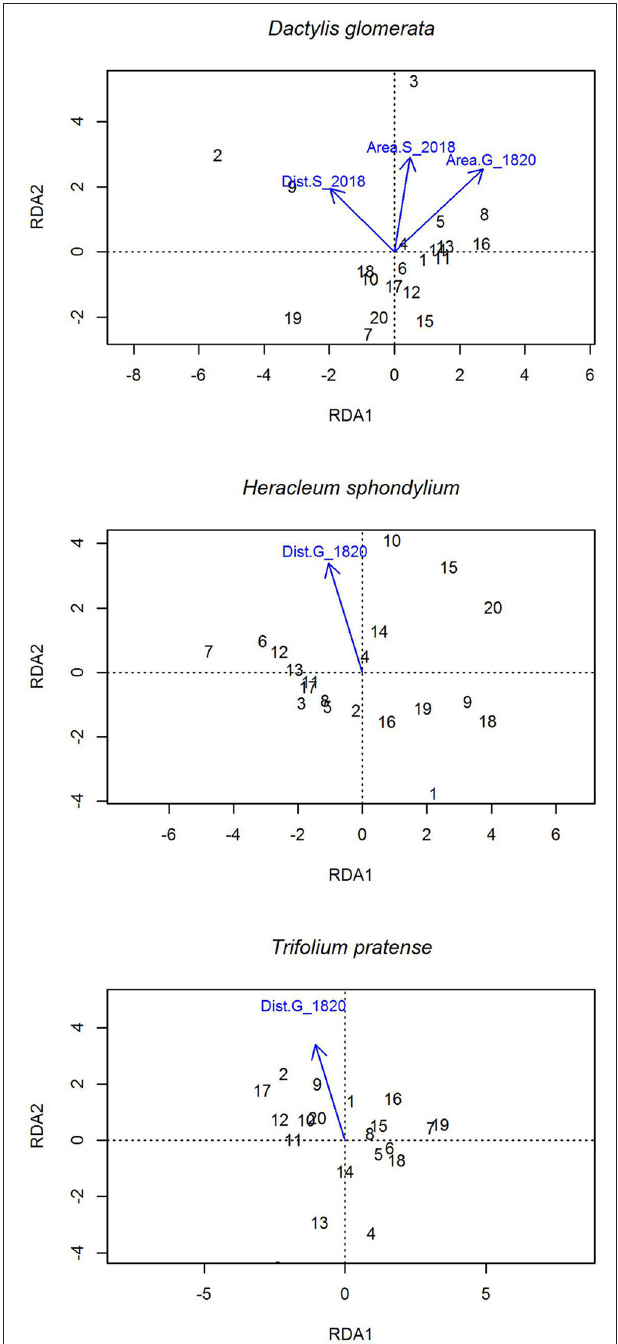
FIGURE 4 | Redundancy analysis (RDA) of AFLP fragment abundance with the explanatory variables used in the linear models for each species ( Table 1 ). Fragment frequencies in D. glomerata populations were correlated with Dist.S_2018 ( r = 0.031, p = 0.041) and Area.S_2018 ( r = 0.35, p = 0.037) and Dist.S_1820 was marginally significant ( r = 0.28, p = 0.064). For H. sphondylium and T. pratense only a correlation with Dist.G_1820 was observed (Hs: r = 0.505, p = 0.003; Tp: r = 0.505, p =